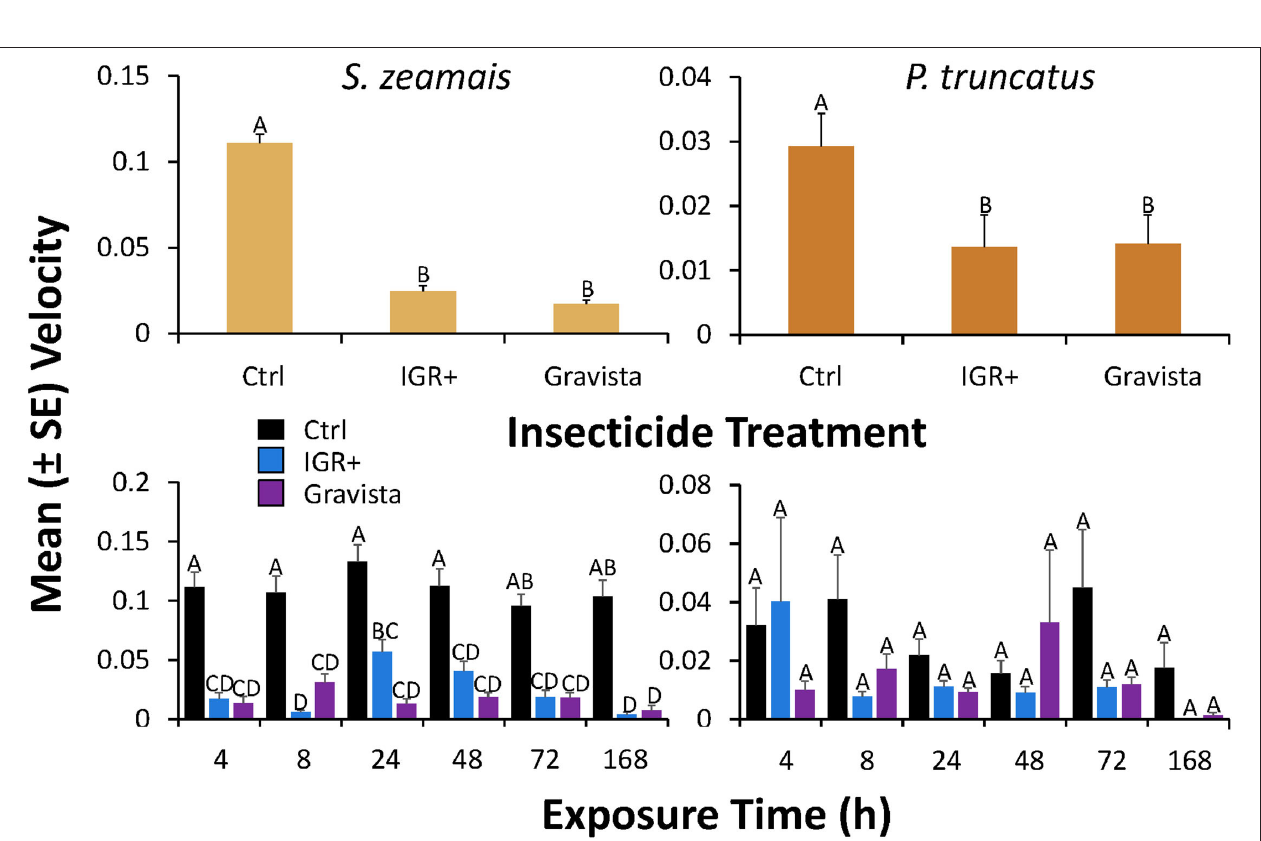
FIGURE 4 | Velocity ( ± SE) by S. zeamais (left column) and P. truncatus (right column) after application of an existing (methoprene + deltamethrin, IGR + ) and novel (methoprene + deltamethrin + synergist, Gravista) commercial formulation of insecticide to concrete compared to a control overall (top panels) or broken down by exposure time (bottom panels) . Bars with shared letters are not significantly different from each other (Tukey HSD, α = 0.05).